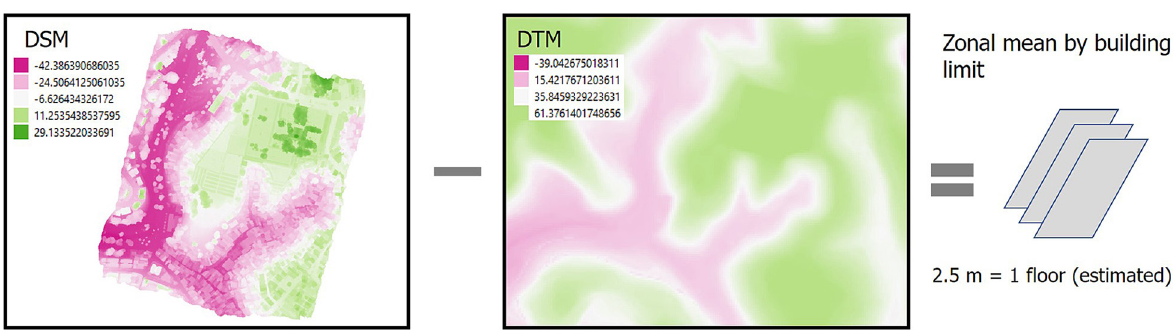
Fig. 5. The zonal mean calculation for slope and building height.